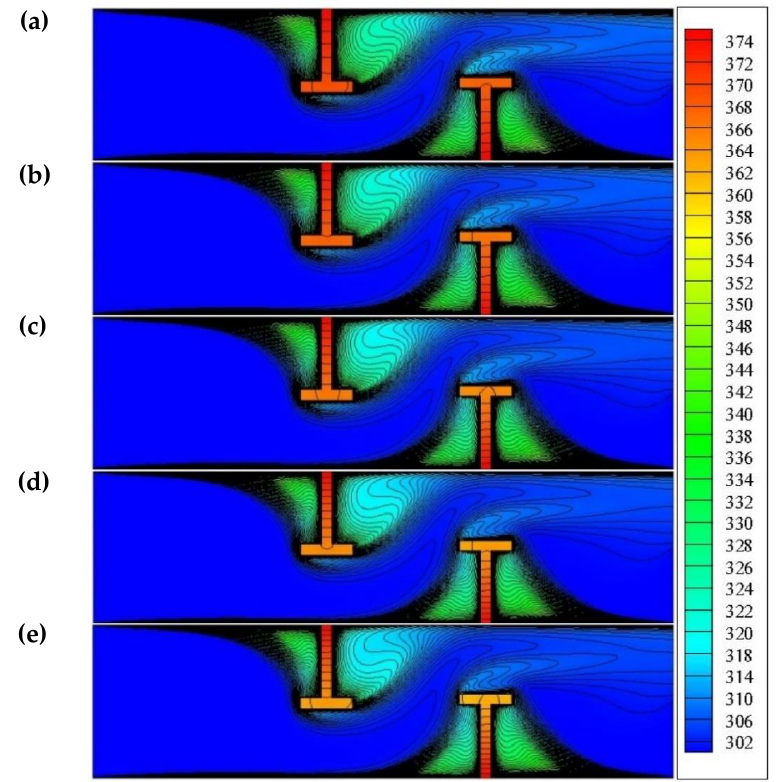
Figure 11. Impact of Re on the thermal fields: Re = ( a ) 12,000; ( b ) 17,000; ( c ) 22,000; ( d ) 27,000; ( e ) 32,000.